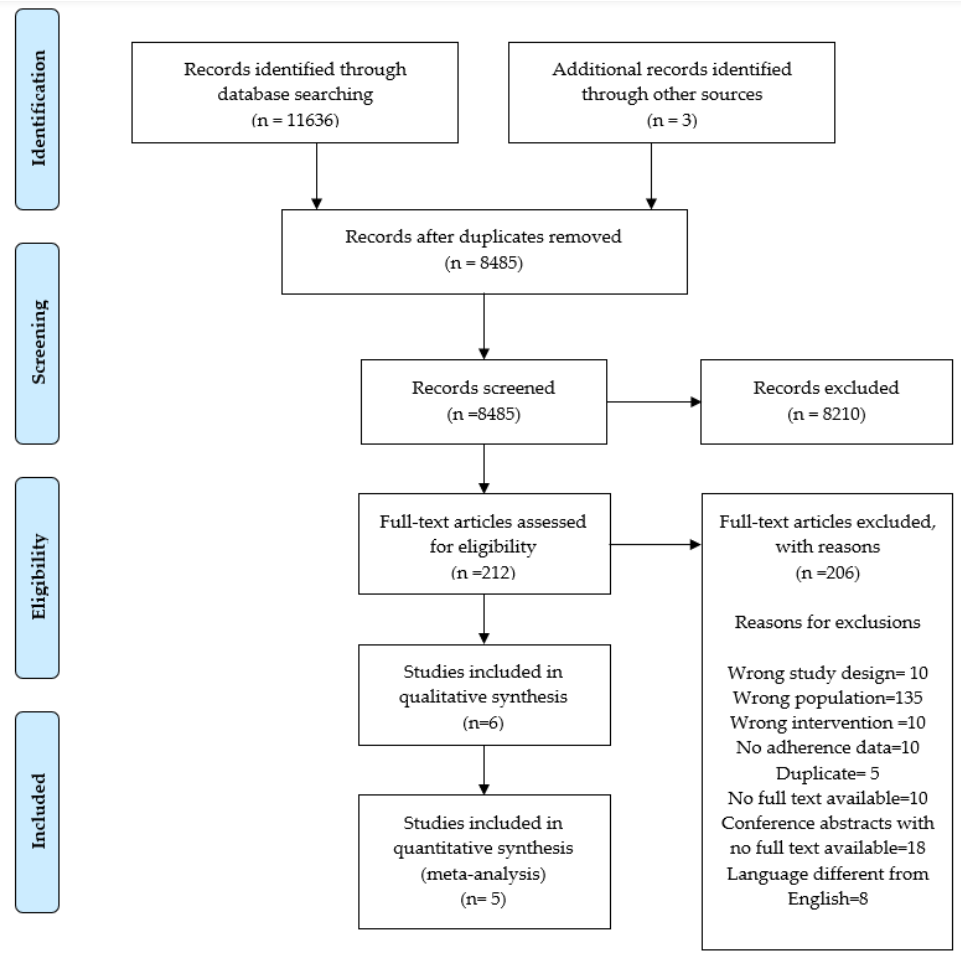
Figure 1. PRISMA flow diagram.